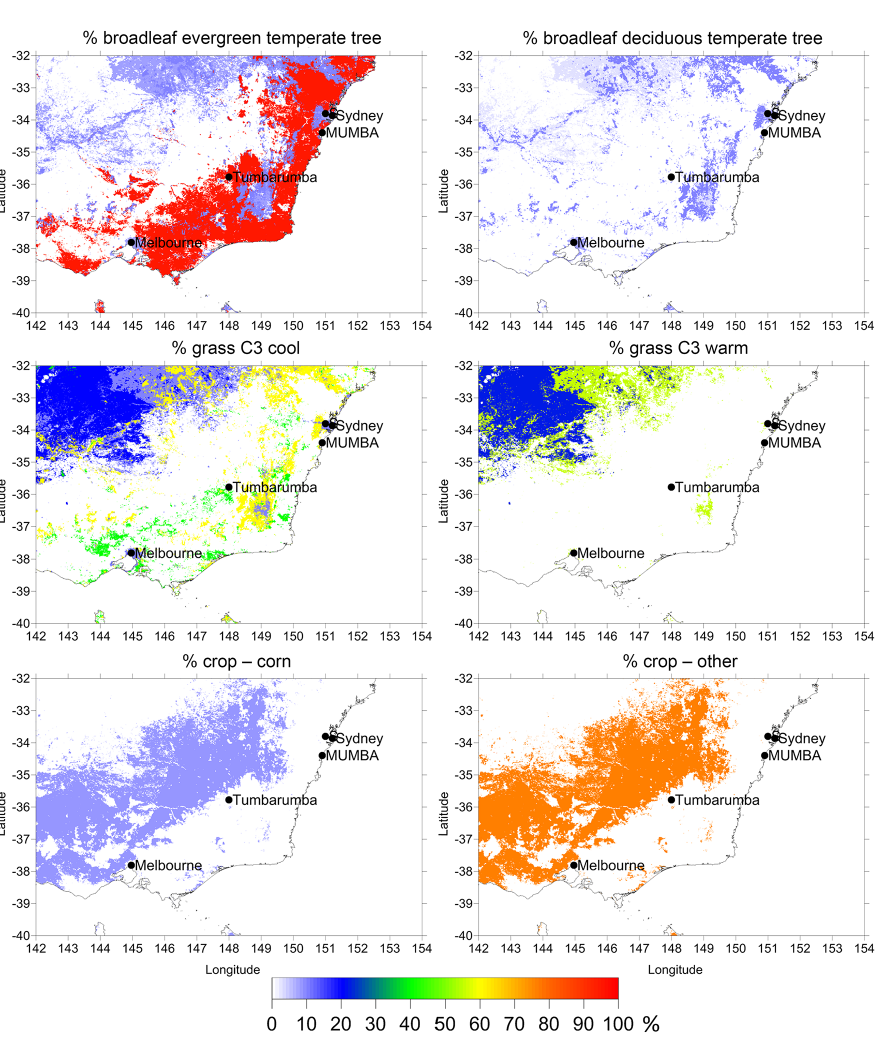
Figure 3. The percentage area covered by the indicated PFTs resulting from splitting the 1km IGBP database into NCAR PFTs in southeast Australia.